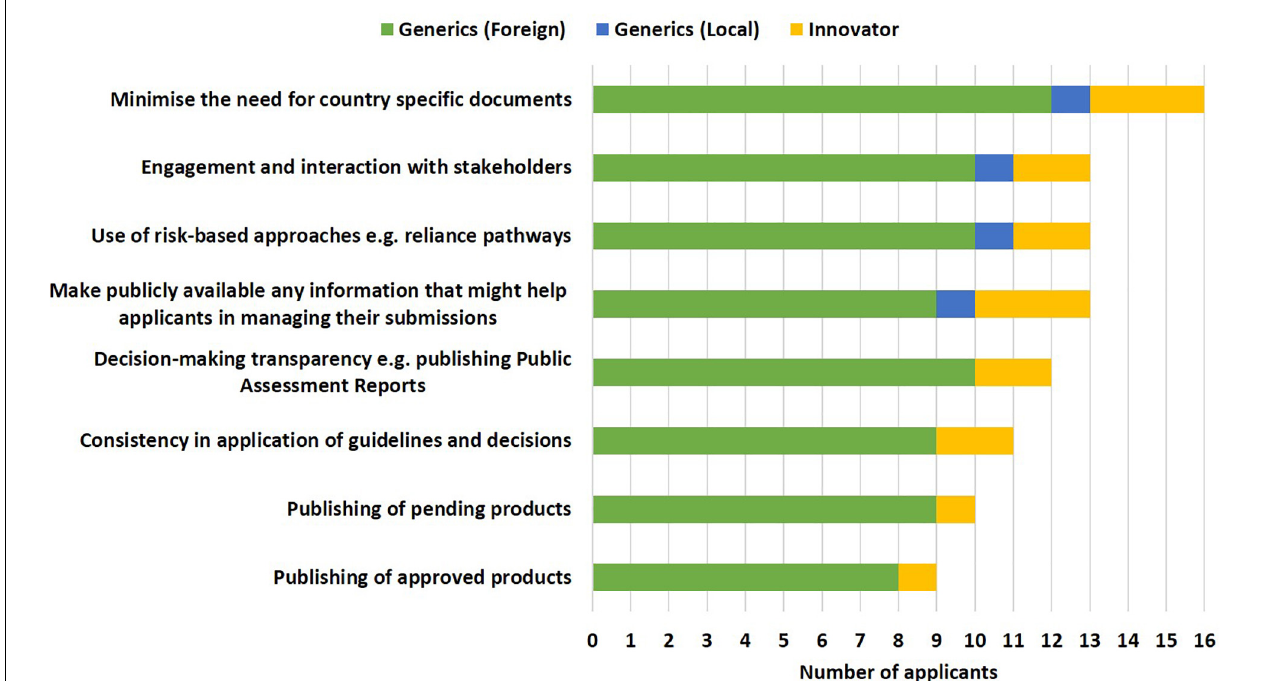
FIGURE 5 | Improving the effectiveness of the ZaZiBoNa initiative according to pharmaceutical industry respondents.